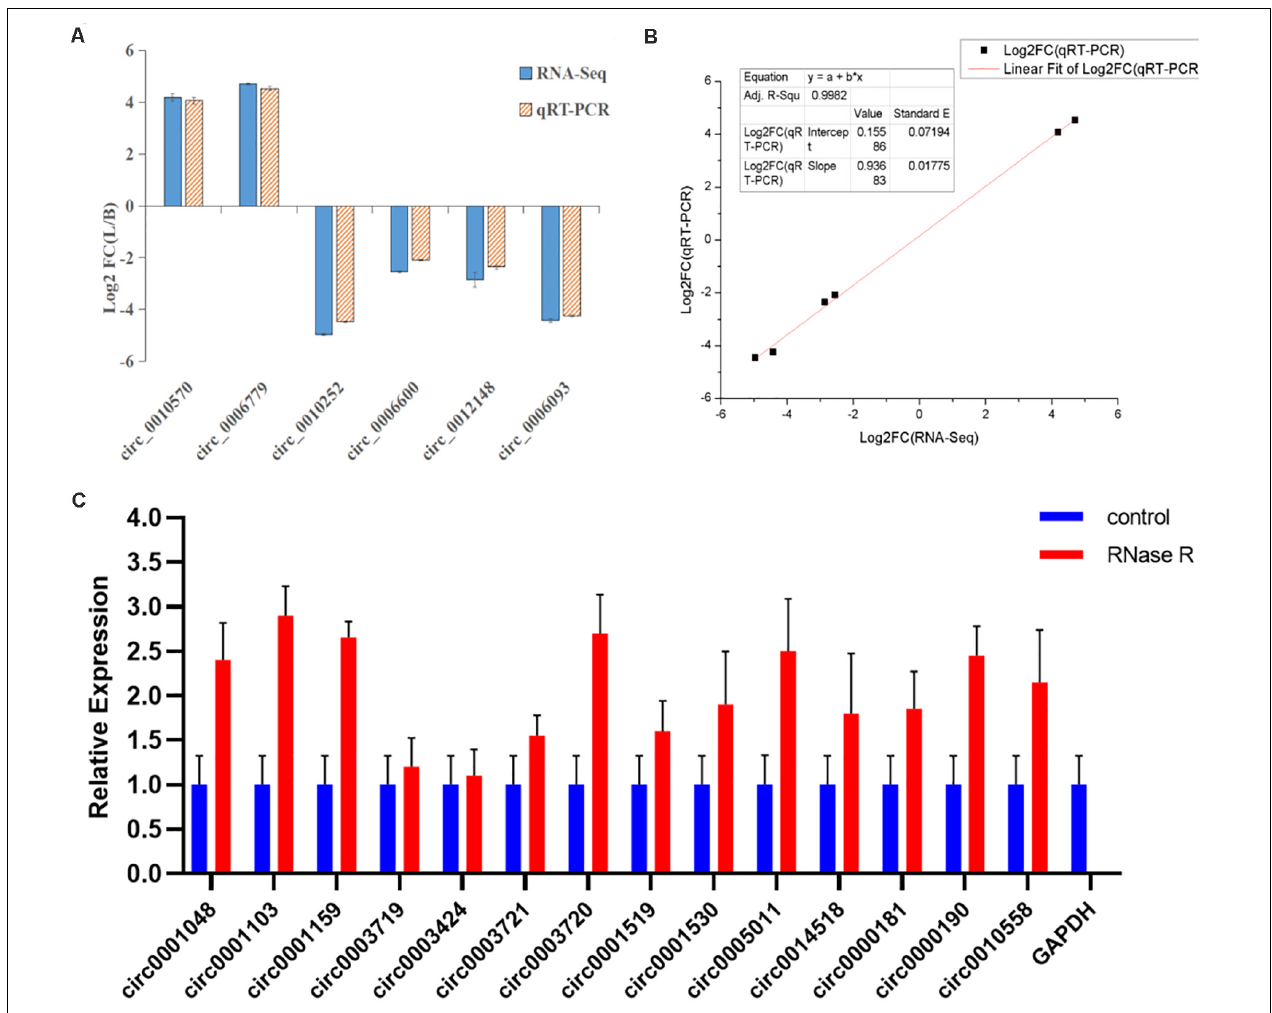
FIGURE 8 | Linear fitting of RNA-seq and qRT-PCR circRNA expression data. (A) The circRNAs related to muscle growth and development were selected for qRT-PCR analysis. (B) The six selected circRNAs showed consistent results between the RNA-seq and qRT-PCR analyses, with a correlation coefficient ( R 2 ) = 0.9982. (C) After RNase R treatment, the expression level of circRNAs and GAPDH were measured. The X -axis indicates circRNAs, and the Y -axis indicates the relative expression level of circRNAs and GAPDH. Error bars indicates ± SD.